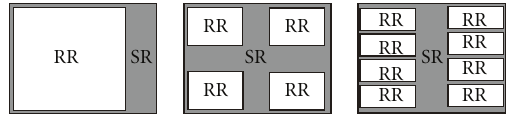
Figure 1: Layout of template-based, generic bitstreams for one, four, and eight reconfigurable regions (RRs) and the static region (SR).